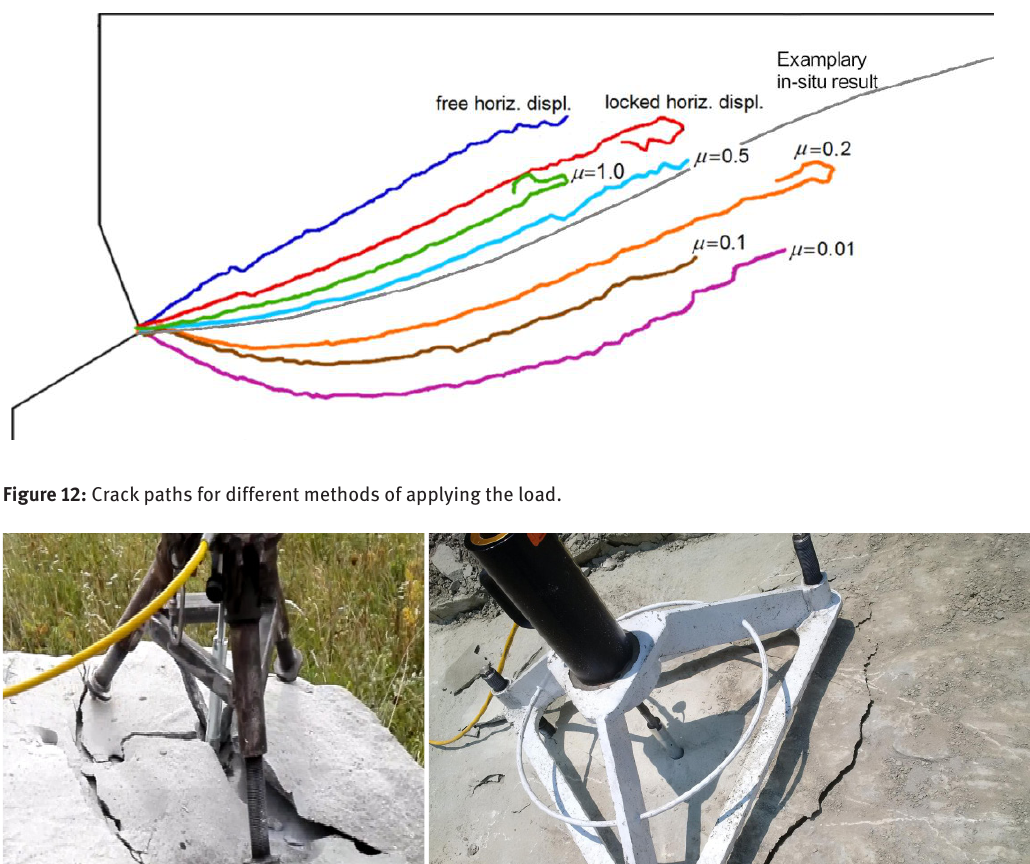
Figure 11: Graph of force dependence on the horizontal range of the crack.